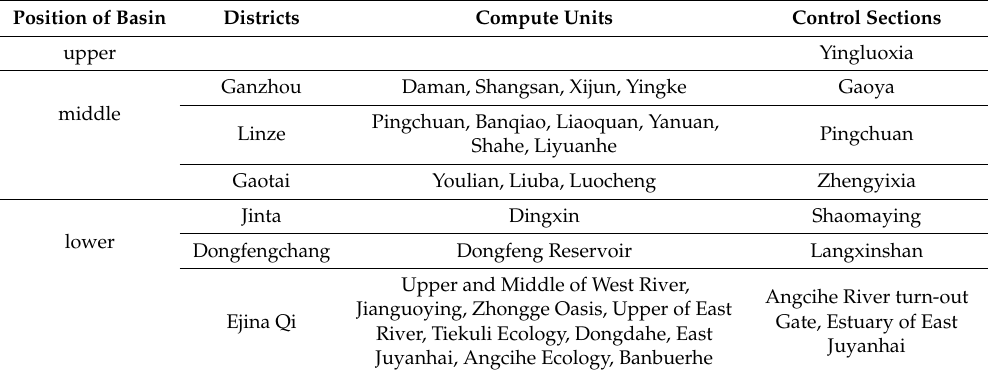
Table 1. Corresponding relationships between computational units and